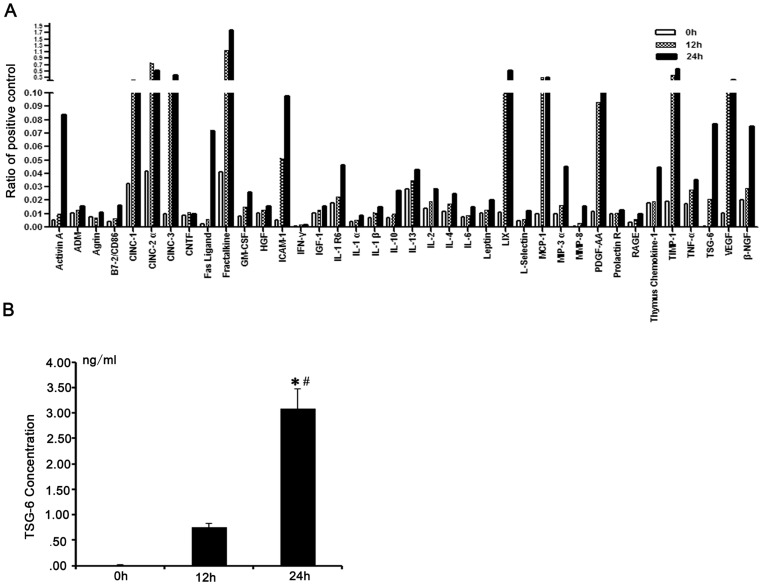
Release of TNFα-stimulating gene (TSG)-6 by mesenchymal stem cells (MSCs).(A). Cytokine profile of 30-folded serum-starved MSCs-conditioned medium (CM) within 24 h was analyzed by rat cytokine antibody array and label-based rat antibody array. Compared with 0 h MSCs-CM, wound healing cytokine TSG-6 was released abundantly by 12 h (52.7-fold) and 24 h (194-fold) serum-starved MSCs. The results were normalized to the positive controls. Similar results were obtained from three independent MSCs-CM samples. (B). TSG-6 in 30-folded serum-starved MSCs-CM within 24 h were measured by Enzyme-linked immunosorbent assays (ELISA). The concentration of TSG-6 in 12 h MSCs-CM was 0.75±0.09 ng/ml (49-fold increase, compared with 0 h MSCs-CM), 24 h MSCs-CM was 3.08±0.22 ng/ml (199.8-fold increase, compared with 0 h MSCs-CM). Three independent samples were placed in three repetitive holes. * compared with 0h MSCs-CM, p <0.05; # compared with 12 h MSCs-CM, p <0.05.